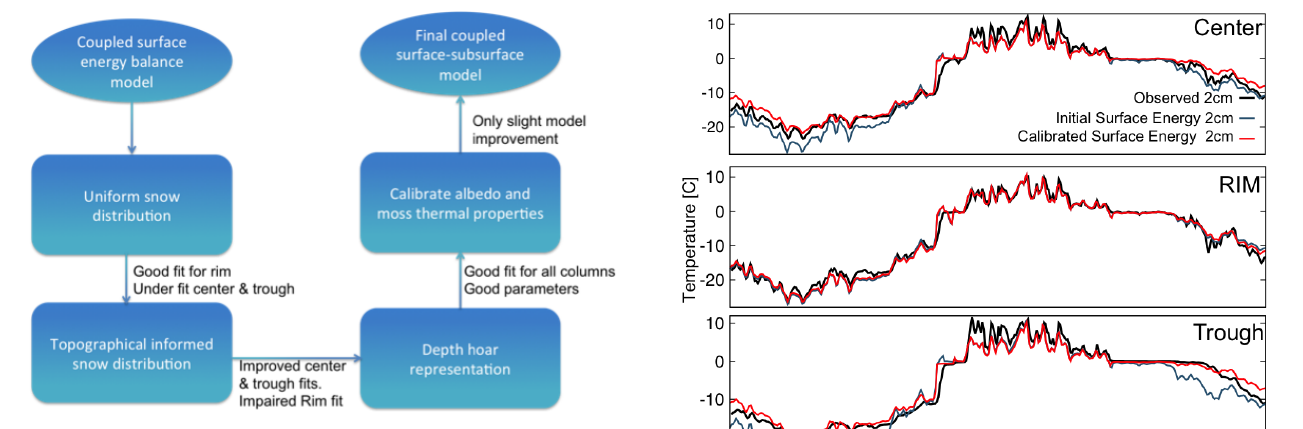
Figure 8. The ModEx cycle applied to the surface energy balance and moss parameters.